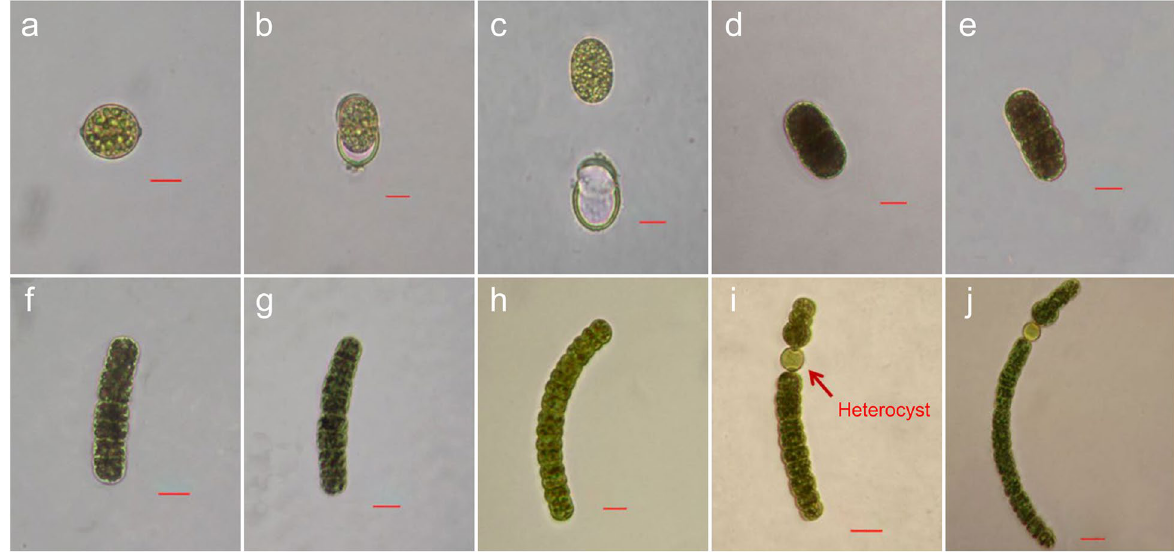
Fig. 4 Dolichospermum circinale akinete germination. Scale bar